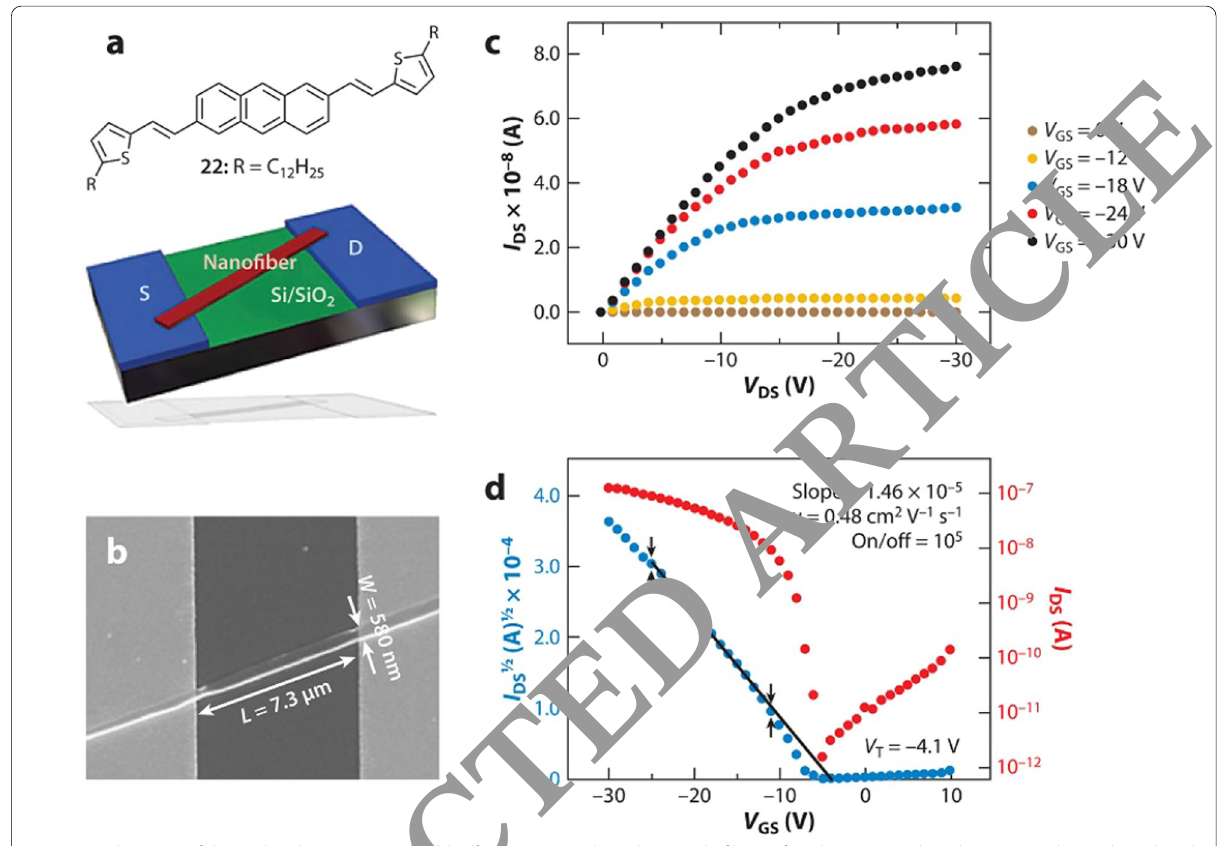
Fig. 9 a Schematic of the molecular structure of field-effect transistors based on single fibers of 6,2-bis (tiny vinyl) anthracene 2,6-bis (2-thienylvinyl) anthracene, b the SEM image of the transistor a ; c and d current–voltage diagrams of transistors based on gate voltage (VGS) and voltage difference between source and discharge terminals (VDS)